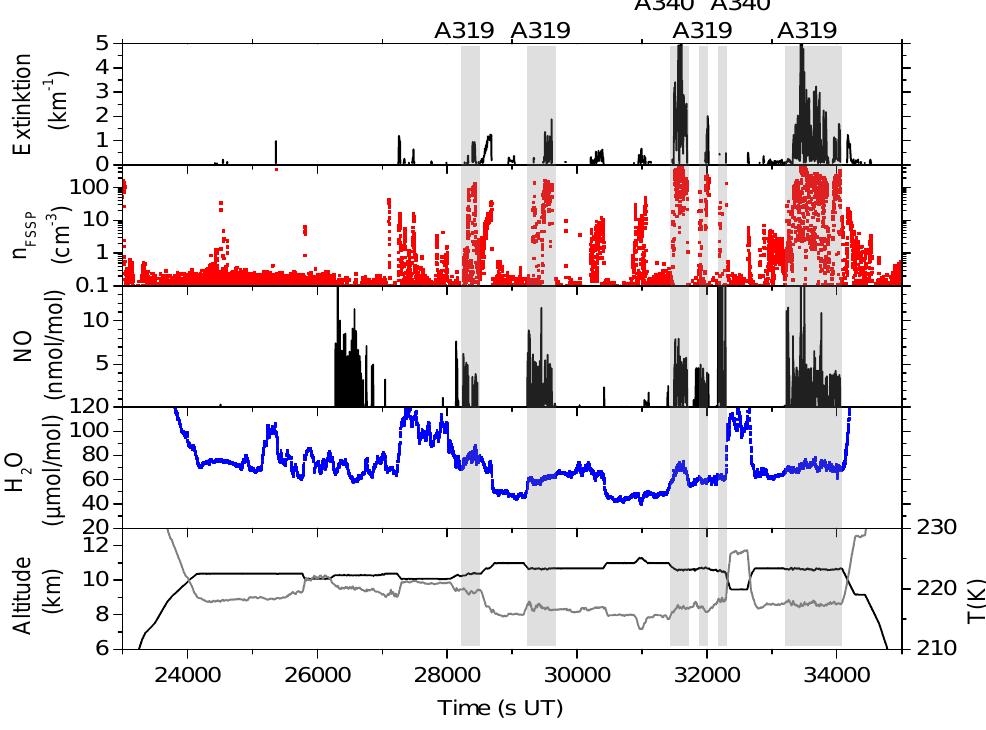
Fig. 5. Contrail flight A on 19 November 2008 above Germany from Oberpfaffenhofen to Hamburg. The flight altitude, temperature, and the H 2 O and NO mixing ratios as well as particle number density detected with the FSSP and the extinction for particles larger than 3µm are shown. Periodic gaps in the NO data are due to calibration events. Sequences of contrail encounters of an A319 and an A340 are marked in